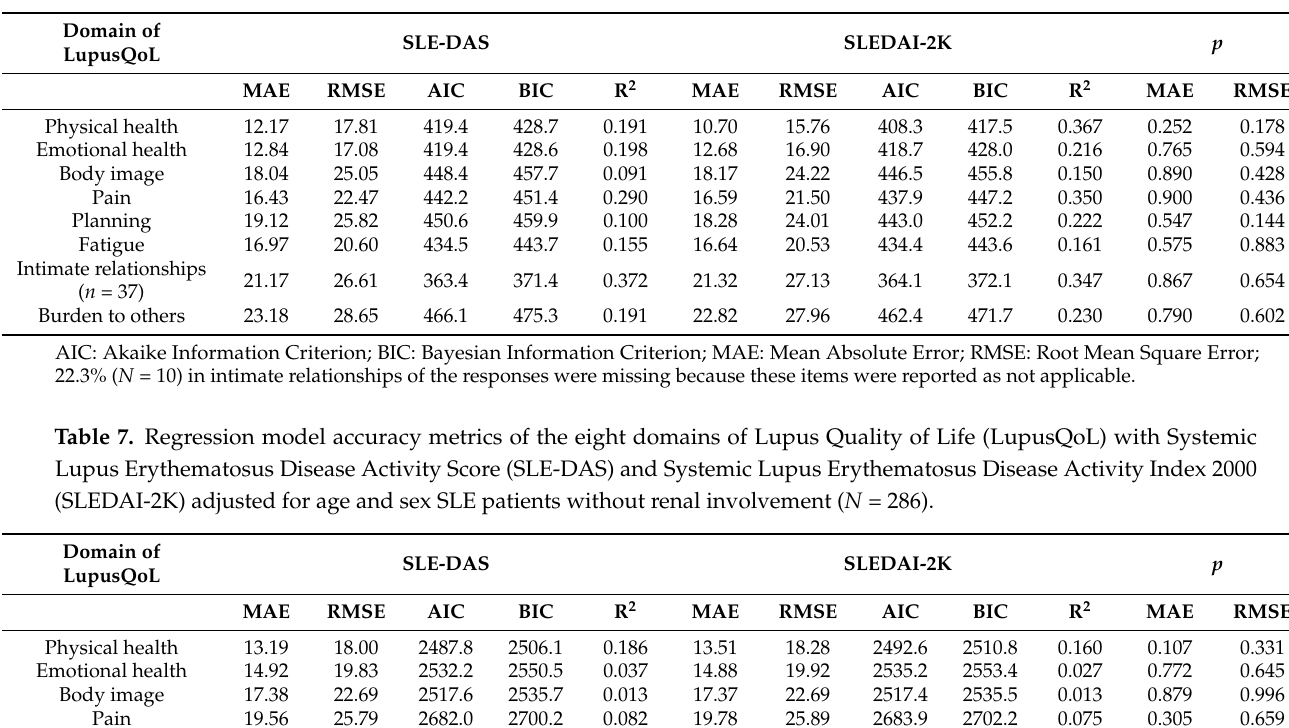
Table 6. Regression model accuracy metrics of the eight domains of Lupus Quality of Life (LupusQoL) with Systemic Lupus Erythematosus Disease Activity Score (SLE-DAS) and Systemic Lupus Erythematosus Disease Activity Index 2000 (SLEDAI-2K) adjusted for age and sex in SLE patients with renal involvement ( N = 47). Domain of LupusQoL